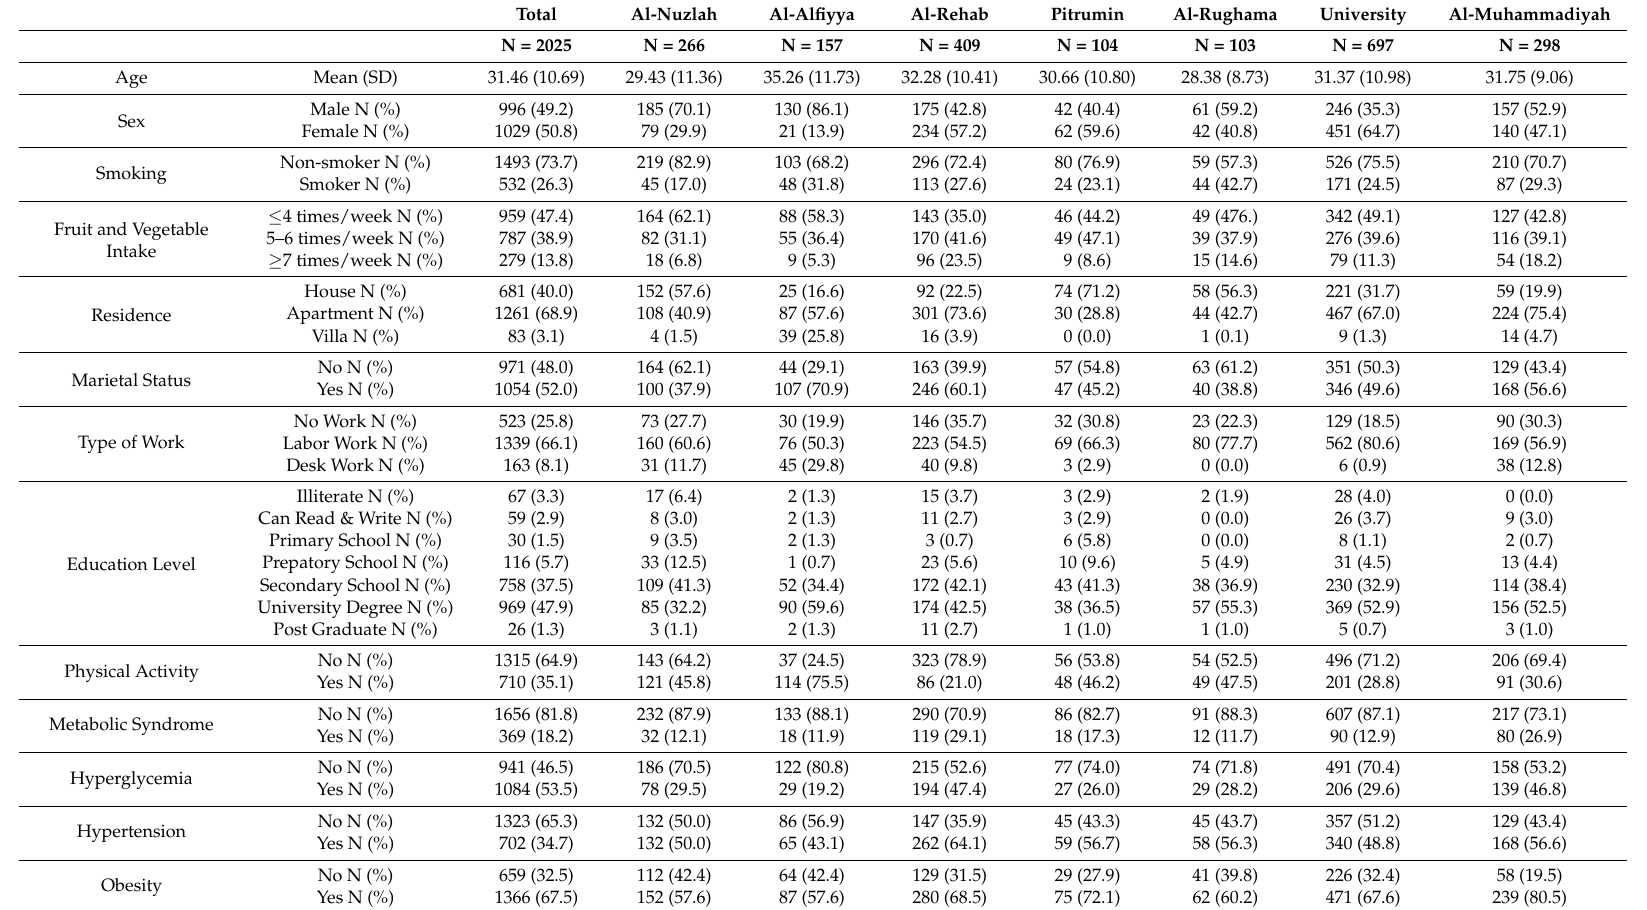
Table 1. Study cohort characteristics by